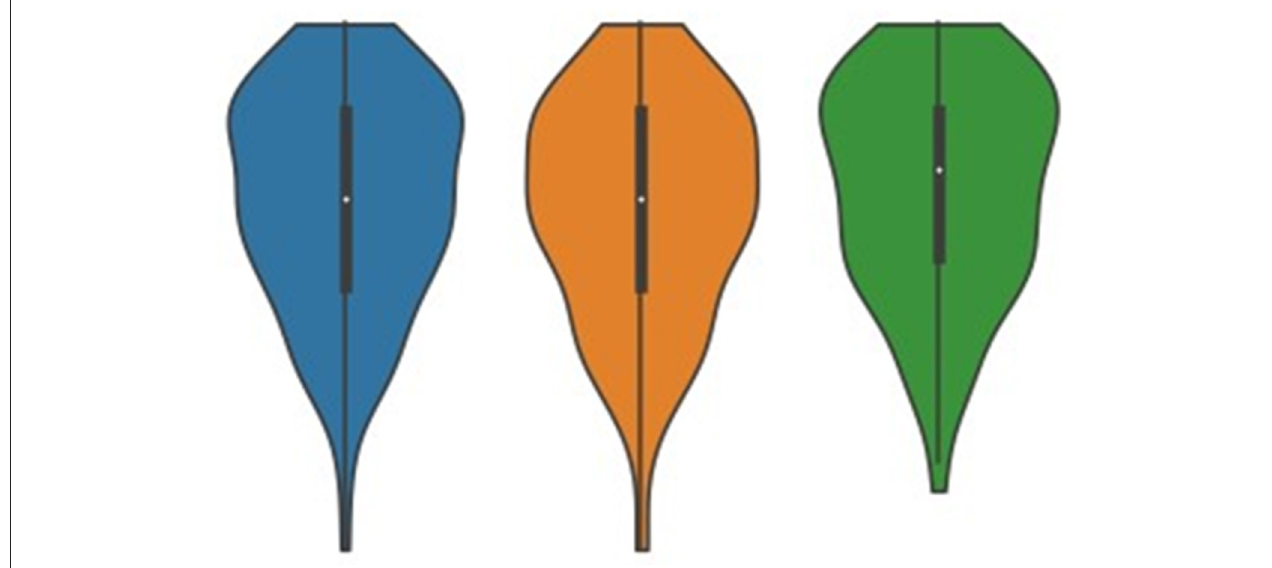
FIGURE 2 | Mood state of all participants (blue) and those between the ages of 41 and 60 years (orange) and 61 years and over (green), using the Brief Emotional Experience Scale. A significant difference ( p = 0.002) was found between the two age groups. The median for each group is indicated by the white dot, with the interquartile ranges shown by the thick black line. The remaining distribution, excluding outliers, are shown by the thin black line. Scores greater than 0 indicate a positive mood state, with scores below 0 indicating a negative mood